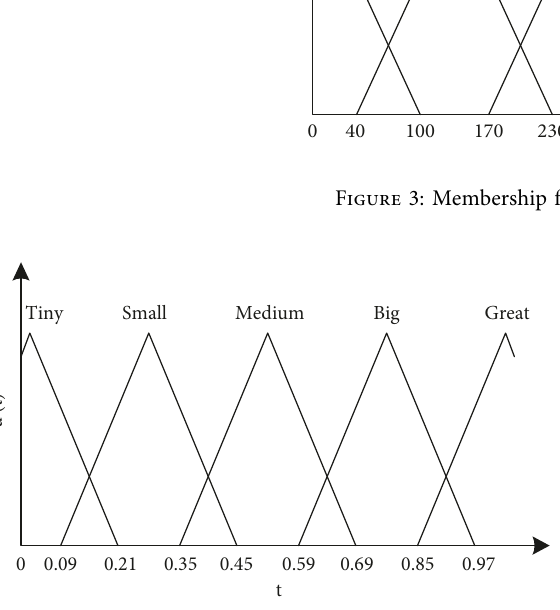
Figure 4: Membership function of the fuzzy subset B